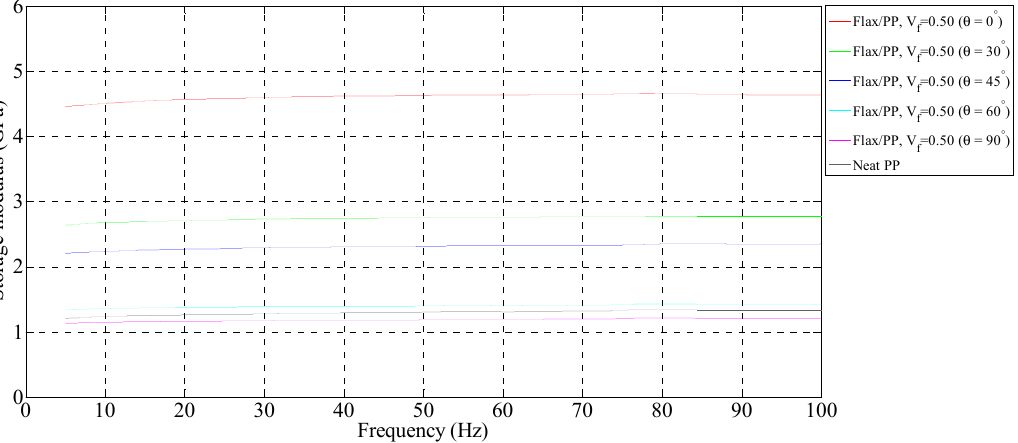
Figure 5. Storage modulus of flax/PP composite samples of different fibre orientations for a fibre volume fraction of 0.50 and a neat PP sample.